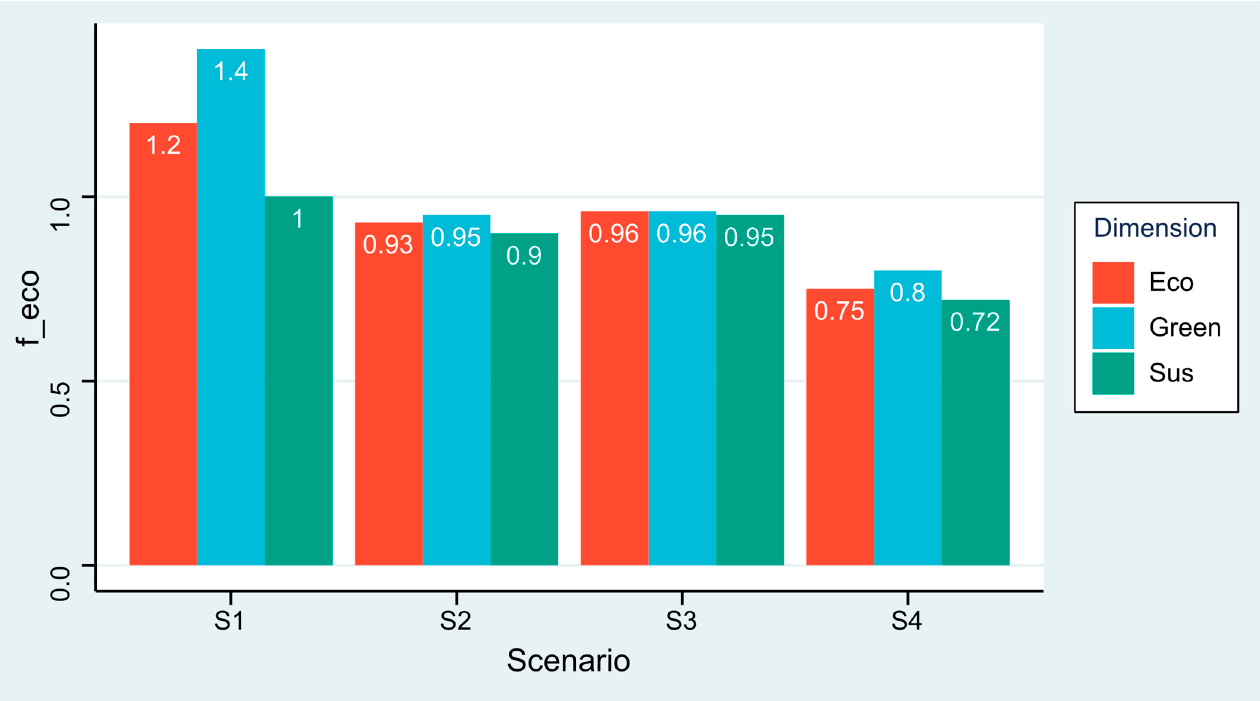
Figure 5. Results of the sensitivity analysis of the sustainability dimension of f eco